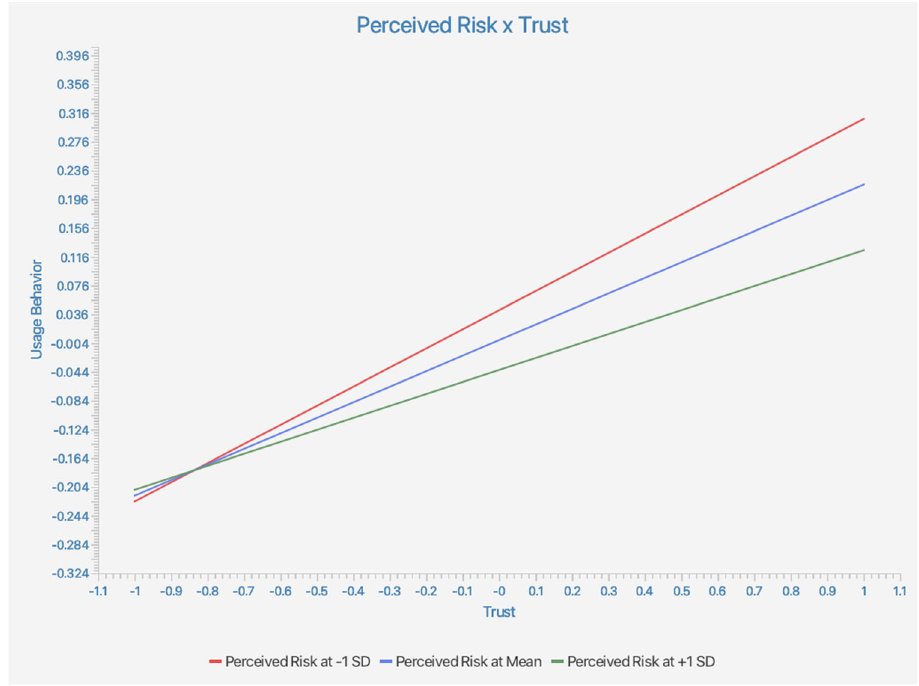
Figure 4. The moderating effect of perceived risk on the relationship between trust and usage be ‐ havior.